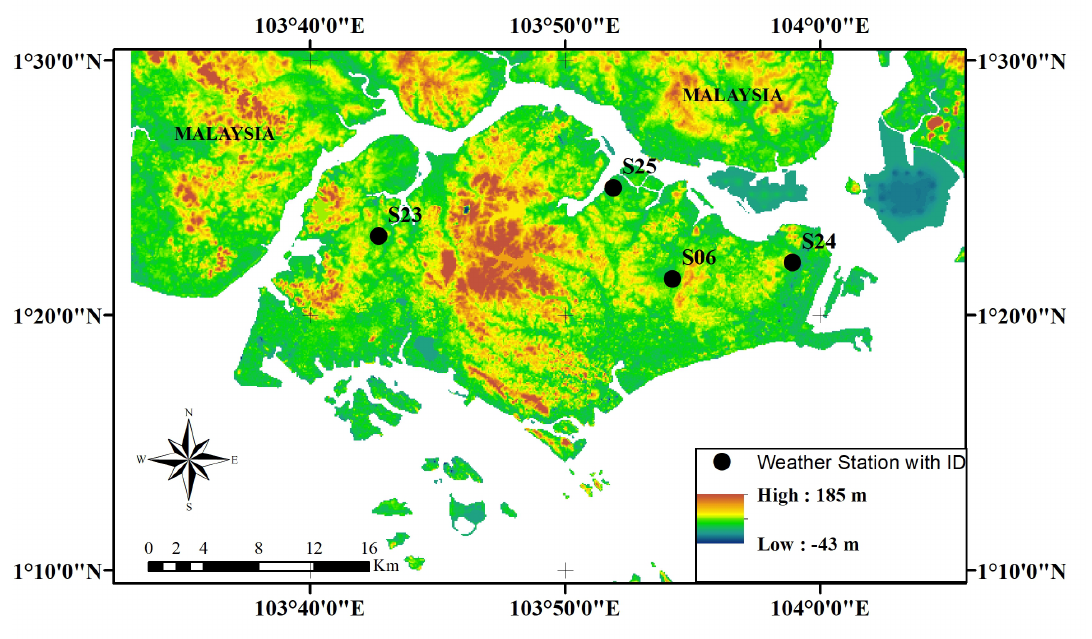
Figure 1. Location of weather stations in Singapore (elevation derived from the 90 m SRTM DEM